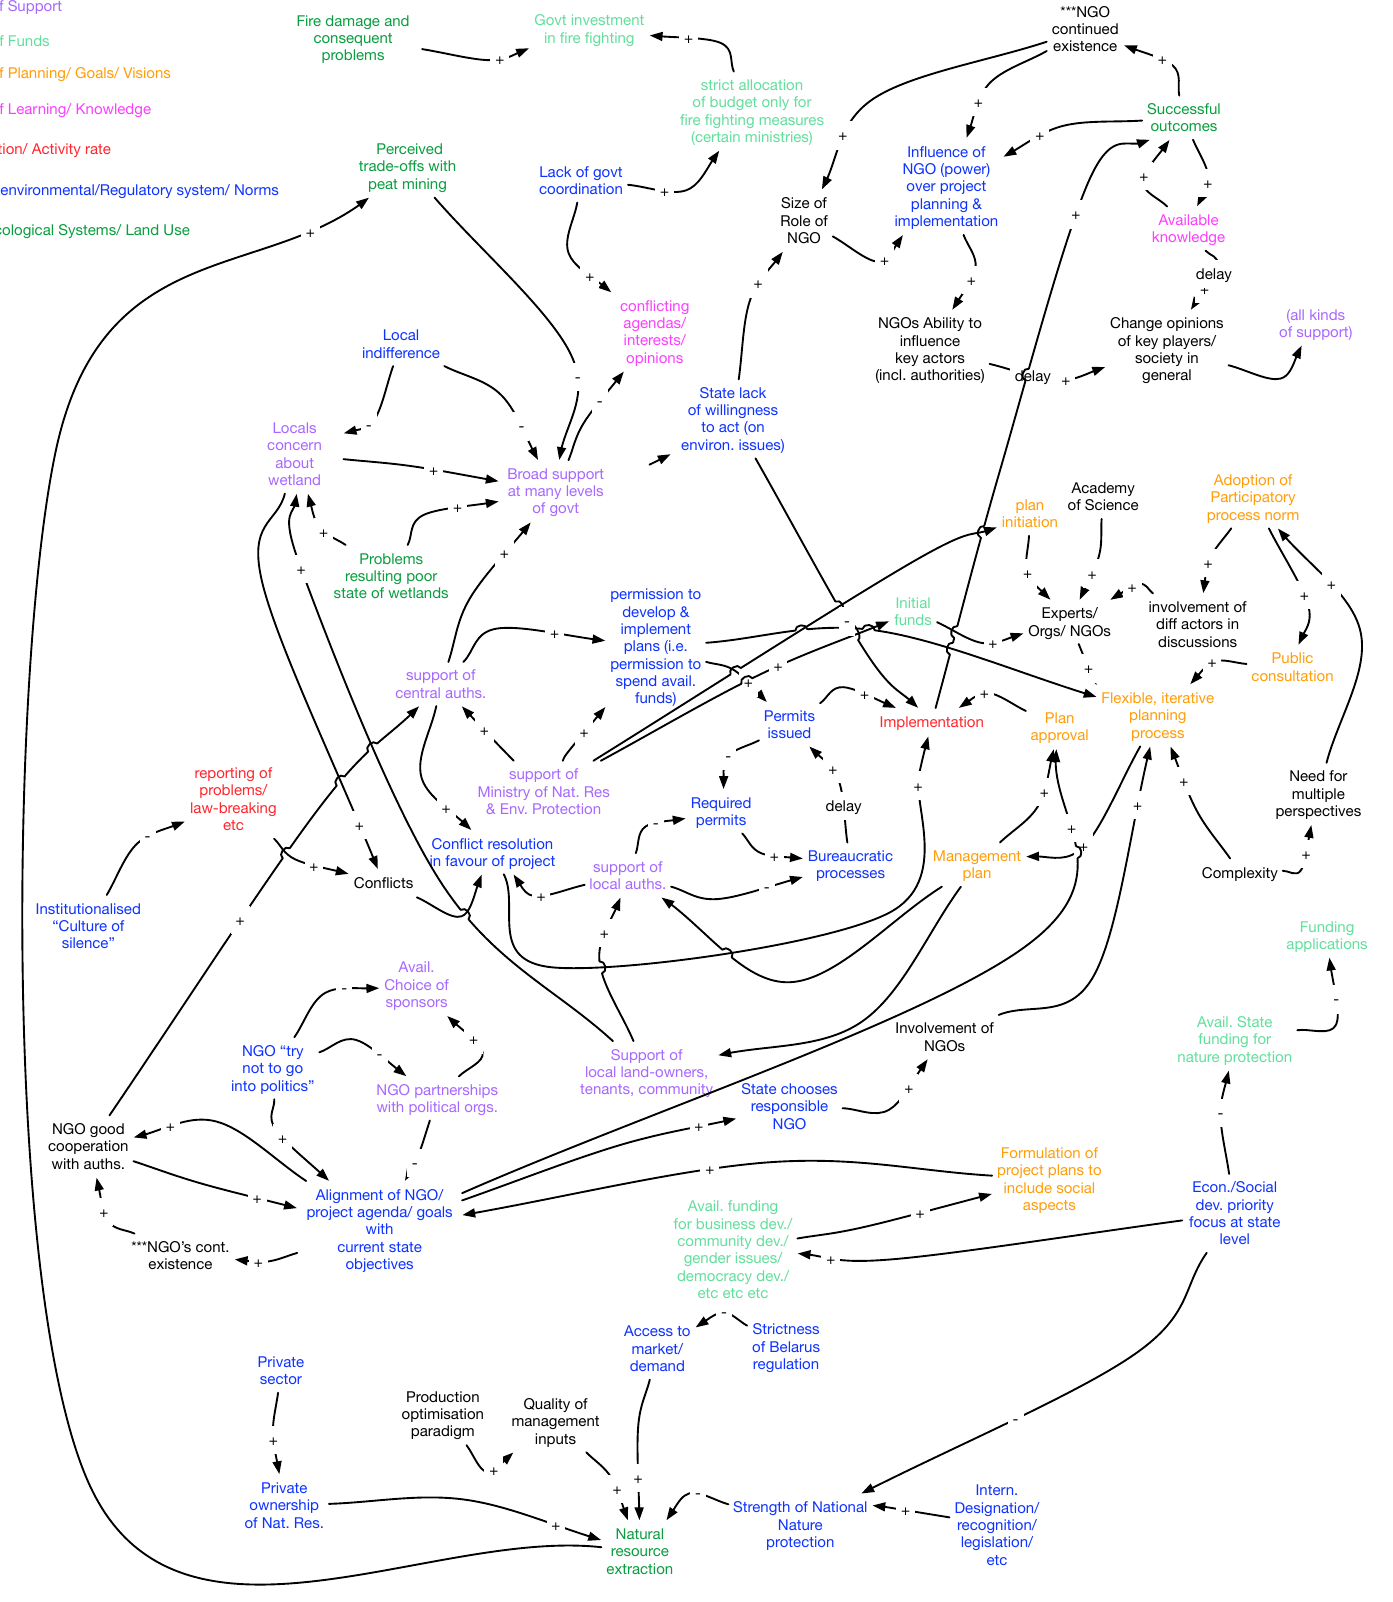
Figure A2:1. Case Bogs, Theme: Institutional and regulatory